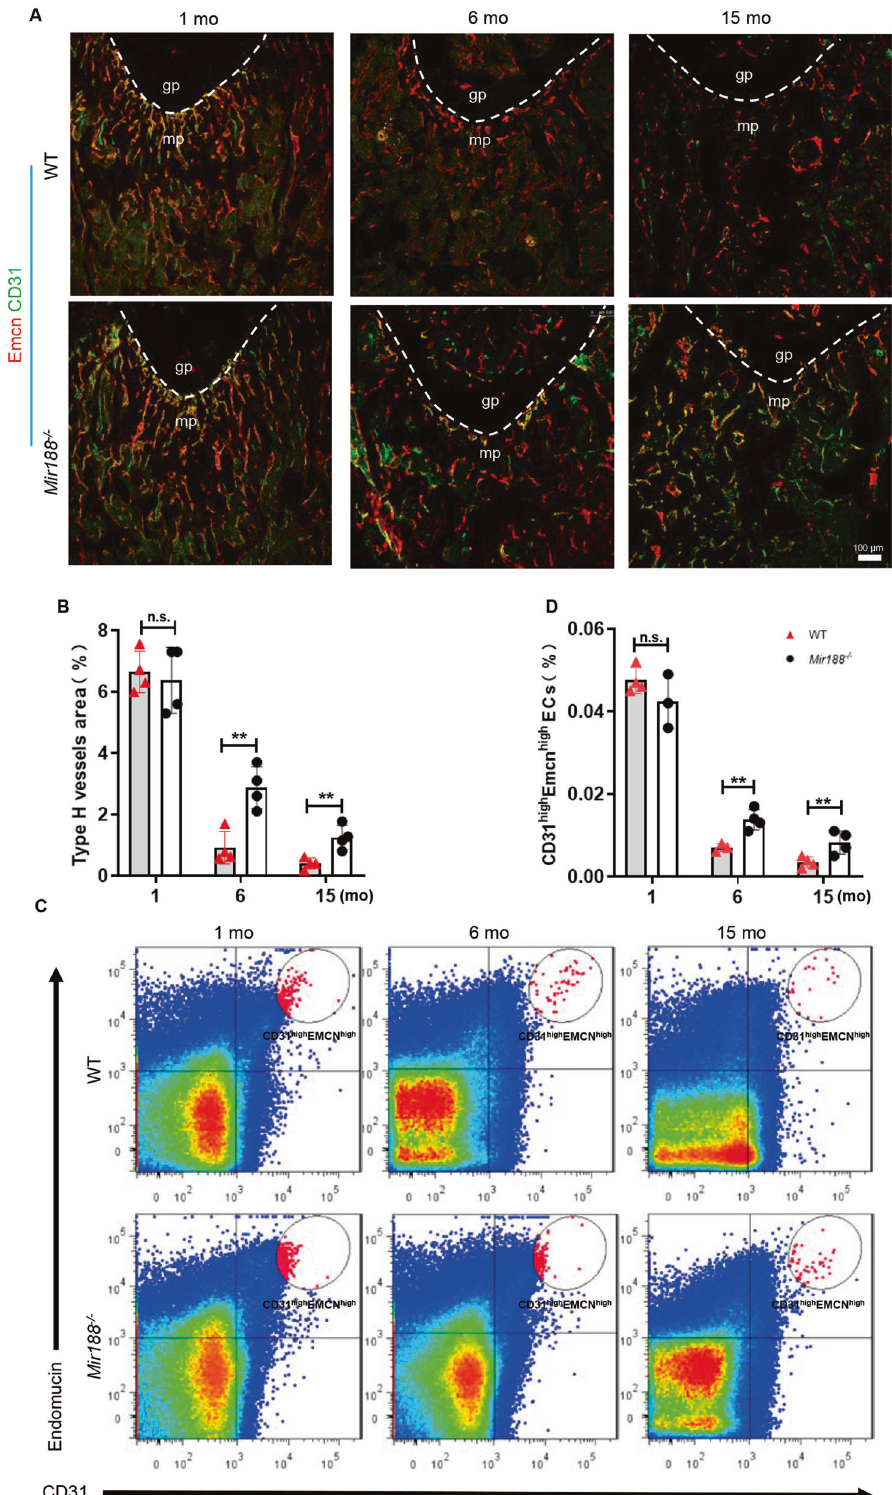
Fig. 1 miR-188 knockout mice showed an alleviated decline in type H vessels with age. A Representative images of coimmunostaining of Emcn (red) and CD31 (green) in femur sections from 1-month-, 6-month-, and 15-month-old WT and miR-188 knockout ( Mir188 − / − ) mice. Scale bar = 100µm. B Quanti fi cation of type H vessels in femur sections from 1-month-, 6-month-, and 15-month-old WT and Mir188 − / − mice. n = 4 mice in each group. C Representative images of Flow-cytometry analysis dot plot from the long bones of 1-month-, 6-month-, and 15-month-old WTand Mir188 − / − mice. D Quantitative fl ow-cytometry analysis of CD31 high and Emcn high cells from the long bones of 1-month-, 6-month-, and 15-month-old WT and Mir188 − / − mice. n = 3 (1-month Mir188 − / − mice and 6-month WT mice), n = 4 (1-month WT mice, 6-month Mir188 − / − mice, 15-month WT mice and 15-month Mir188 − / − mice). gp growth plate, mp metaphysis, mo month. Data are shown as the mean ±SD. n.s. no signi fi cance; ** P <0.01 by Student ’ s t test. Cell Death and Disease (2022)